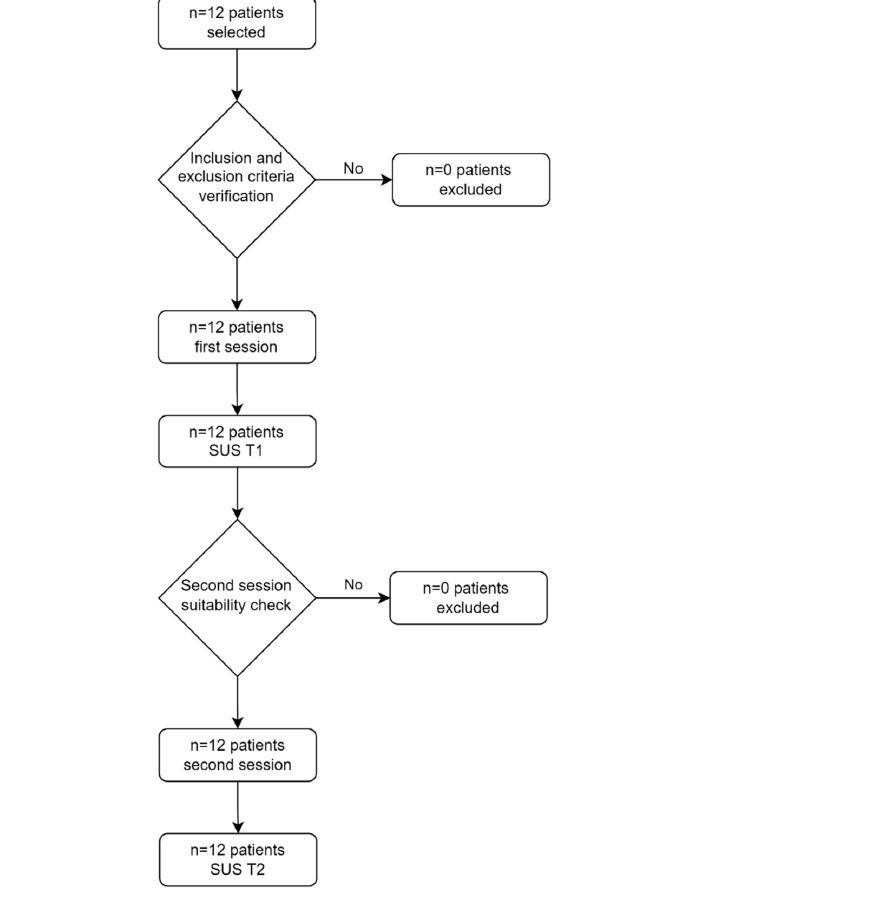
Figure 6. Patients’ flowchart. Table 2. Adopted convention for the interpretation of the SUS values as Adjective Ratings. The interpretation complies with Bangor et al.’s classification [52]. Table 3. Study population description.